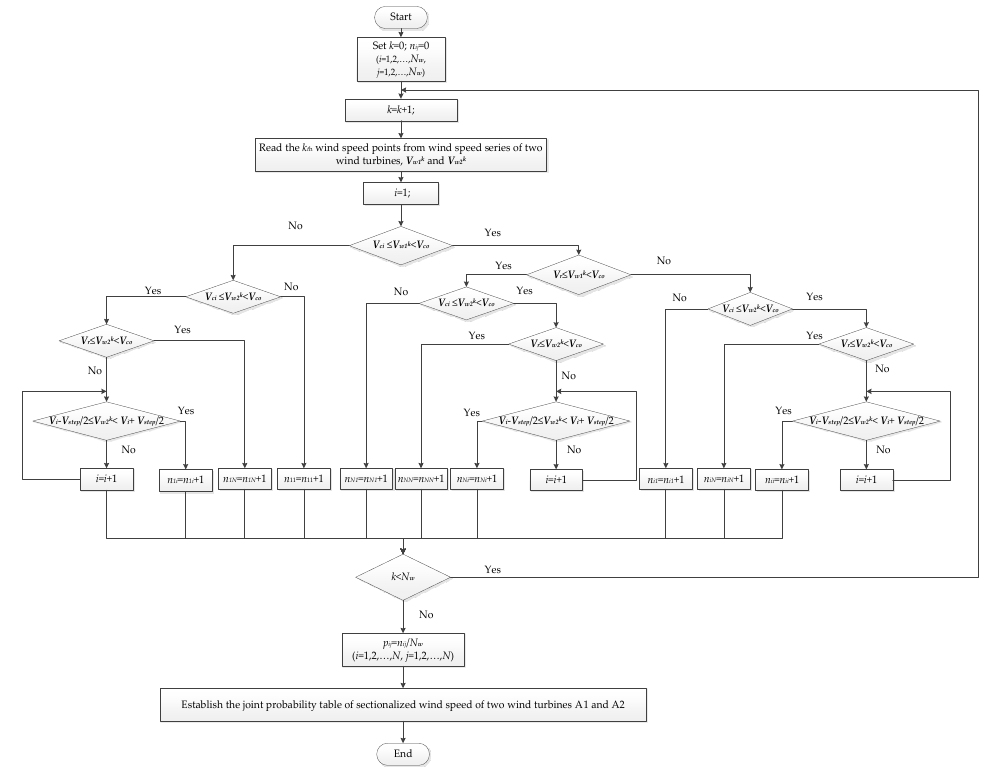
Figure 2. Flow chart of establishing the joint probability table of sectionalized wind speed of two wind turbines A1 and A2.